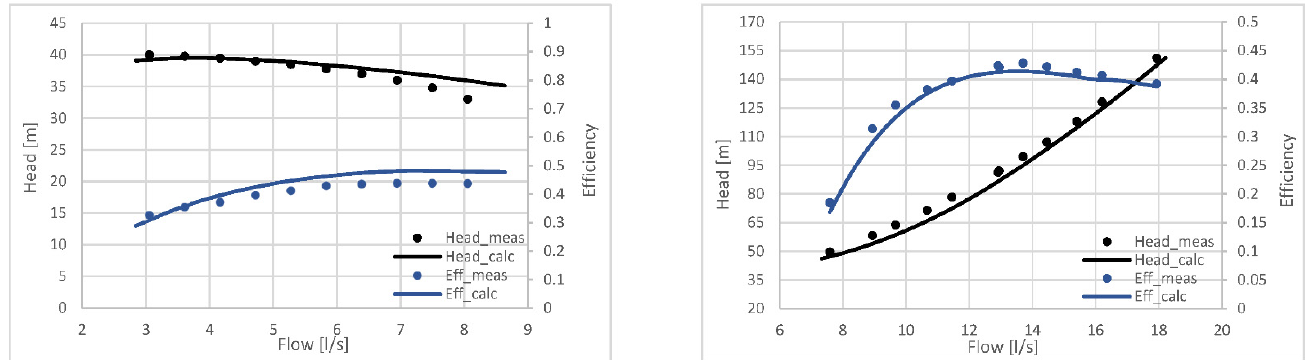
Figure 7. ( A ) Head and efficiency for the PAT 40-335 (ns = 9.05) in pump operation. ( B ) Head and Figure 7. ( left ) Head and efficiency for the PAT 40-335 (ns = 9.05) in pump operation. ( right ) Head efficiency for the PAT 40-335 (nst = 5.52) in turbine operation. and efficiency for the PAT 40-335 (nst = 5.52) in turbine